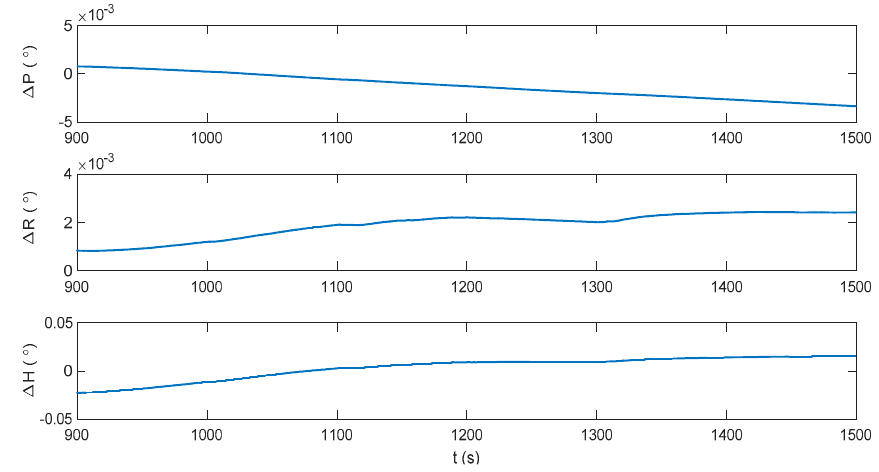
Figure 16. Attitude error of the IMM-aided ZUPT solution during the DVL outage.